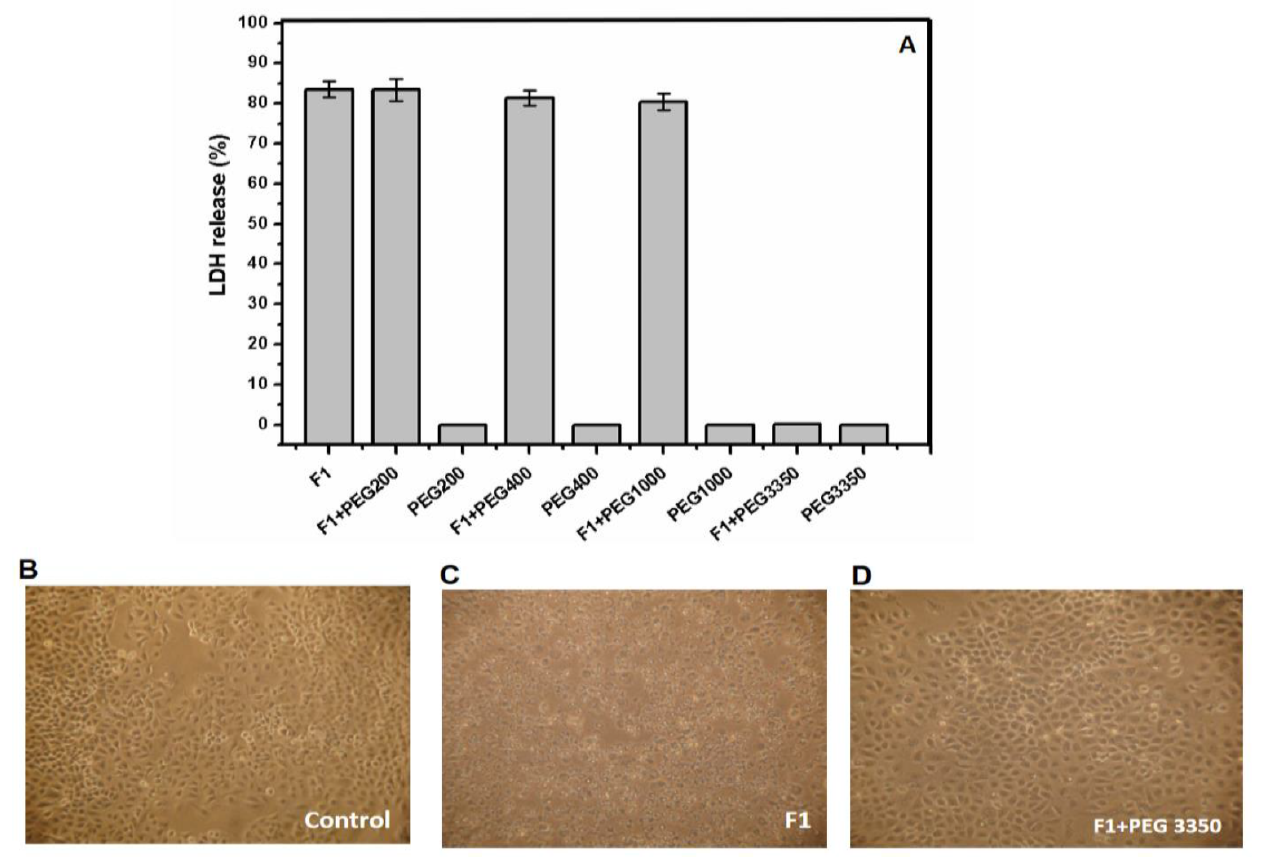
Figure 3. PEG as osmotic protectants in A549 cells in the presence of F1 fraction. A . Cells were previously incubated with different PEG before adding 50 μg of F1 fraction. The buffer used was 50mM phosphate, pH 7.4. B, C and D : Damage to the cells by 50 μg/mL of the F1 fraction was inhibited by the addition of PEG